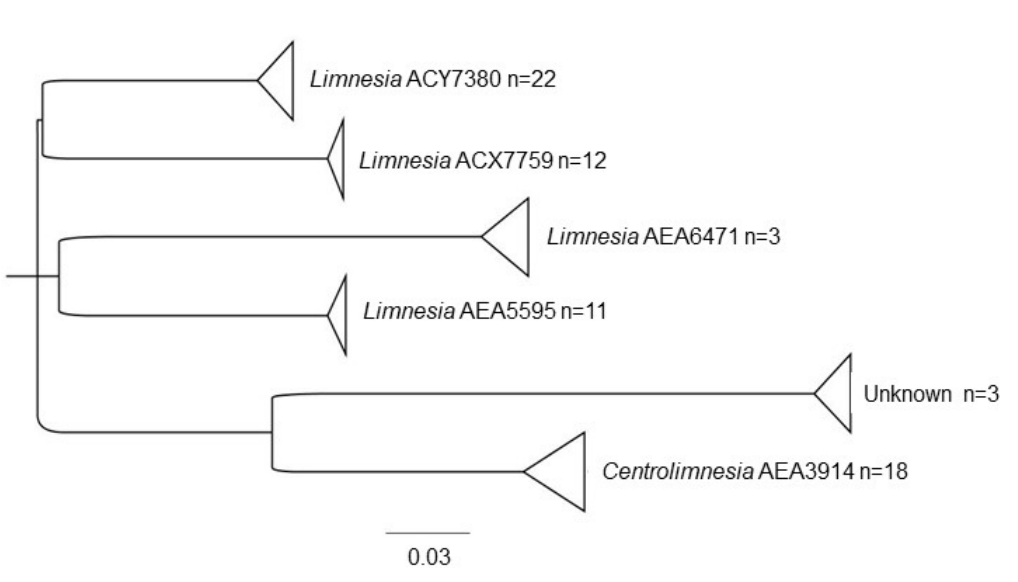
Figure 8. NJ tree for Limnesiidae family.